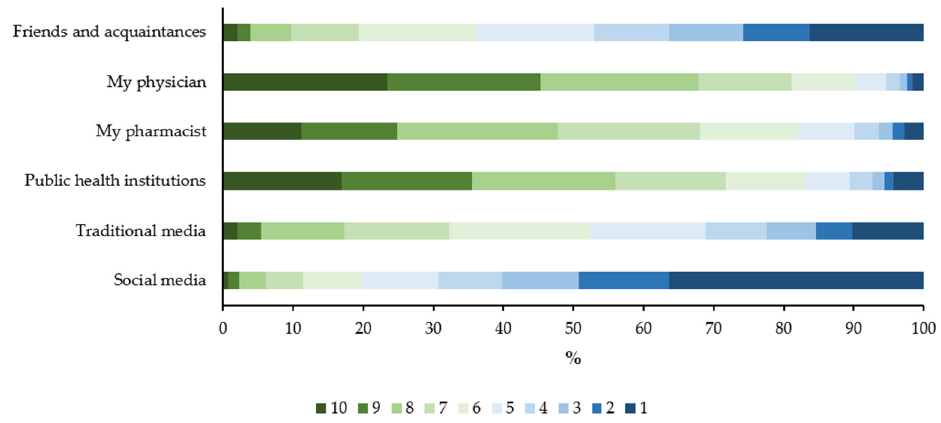
Figure 2. Participants’ trust in different information sources on influenza vaccination (10 indicates the highest trust).